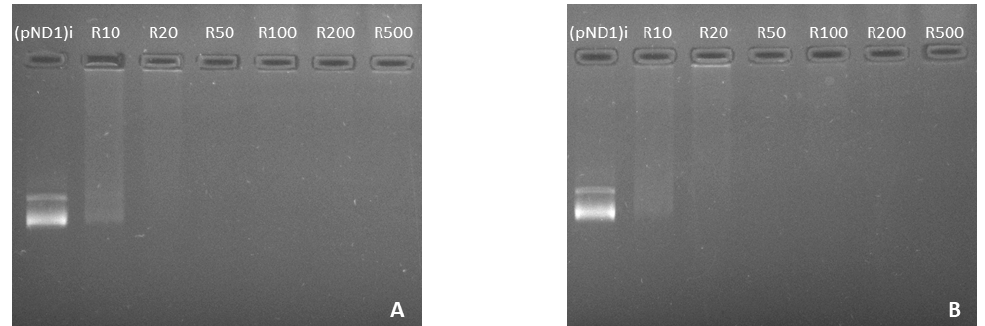
Figure 6. Agarose gel electrophoresis of the initial pND1 solution ((pND1)i) and supernatants resulting from the formulation of PEI–DQA (10 kDa)/TAT/pND1 systems (PEI–DQA N/P = 10, 20, 50, 100, 200, and 500, and TAT N/P = 2) ( A ) and PEI–DQA (25 kDa)/TAT/pND1 systems (PEI–DQA N/P = 10, 20, 50, 100, 200, and 500, and TAT N/P = 2) ( B ).